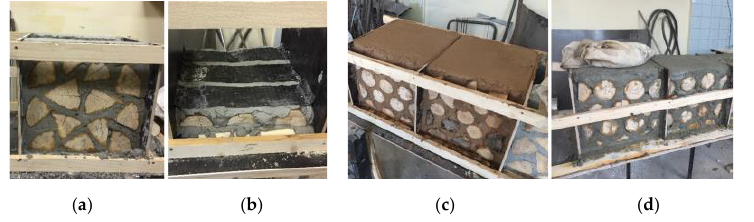
Figure 4. Laboratory specimens with the different types of mortars: ( a , b ) lime mortar; ( c ) clay; ( d ) cement mortar.